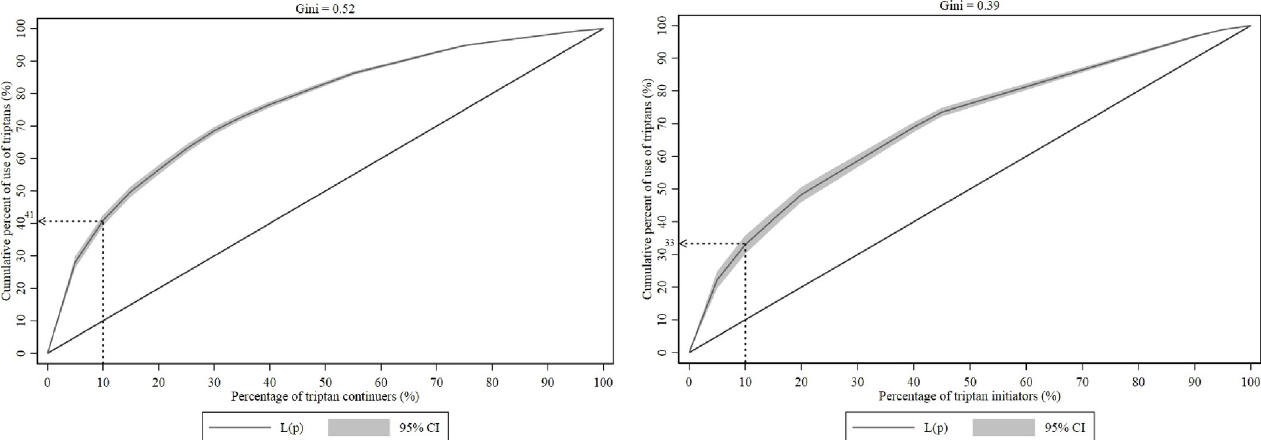
Fig 3. Lorenz curves for triptan users during pregnancy (continuers and initiators). The curved line indicates the proportion of triptan use accounted for by the proportion of the most intensive users. The top 10% of the users consumed 41% (95% CI: 39.2% - 42.5%) of the triptan volume among continuers and 33% (95% CI: 30.3% - 35.8%) among initiators. The Gini coefficients were 0.52 for the continuers and 0.39 for the initiators, indicating some inequality in triptan use.